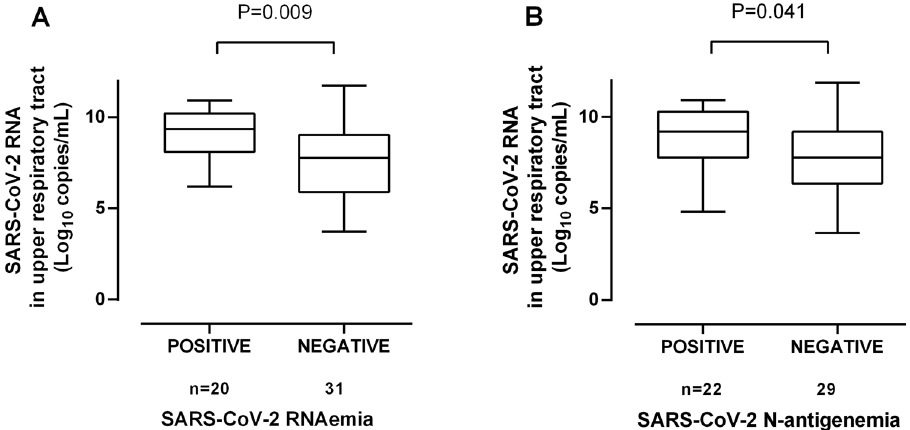
Figure 1. Box-plot depicting SARS-CoV-2 RNA load (in copies/ml) in nasopharyngeal specimens at the time of molecular diagnosis of SARS-CoV-2 infection in critically ill patients with or without subsequent virus RNAemia ( A ) or N-antigenemia ( B ). P values are shown for comparisons.